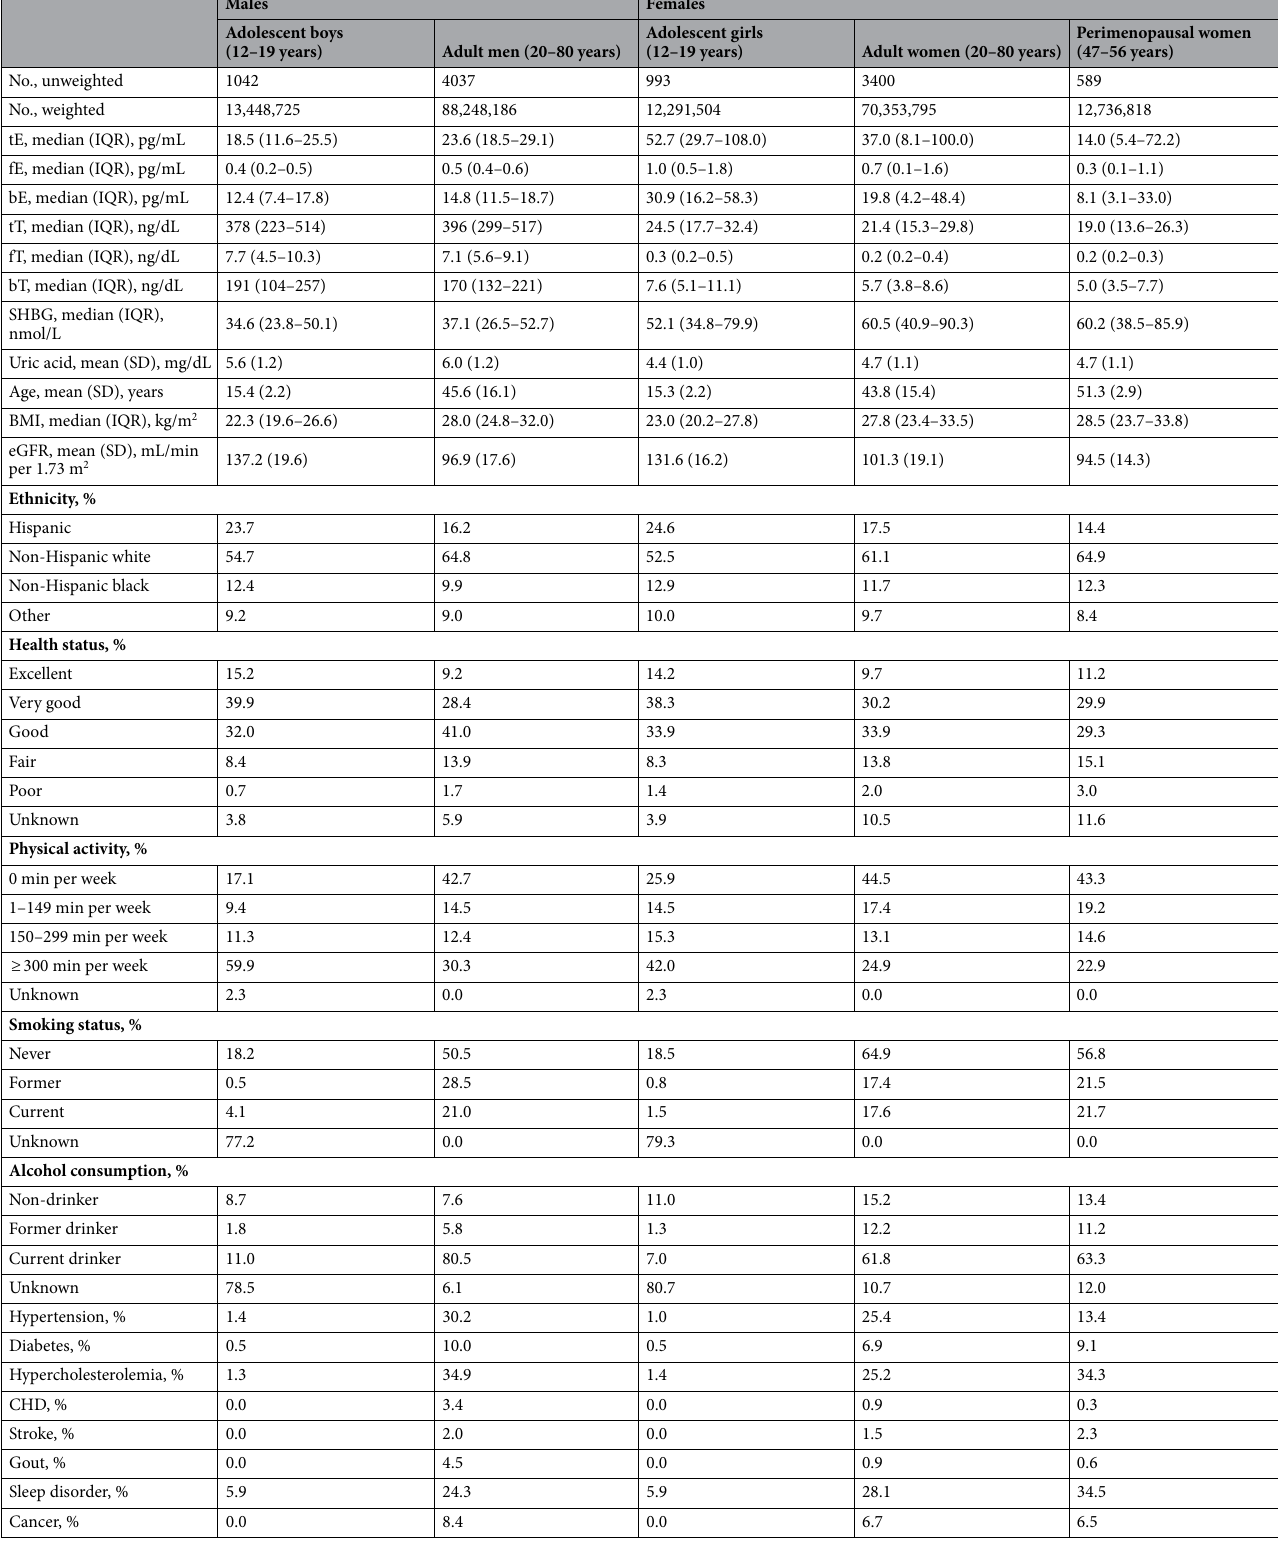
Table 1. Characteristics of the cohort stratified by sex and age. bE, fE or tE bioavailable, free or total estradiol; BMI body mass index; bT, fT or tT bioavailable, free or total testosterone; CHD coronary heart disease; eGFR estimated glomerular filtration rate; IQR interquartile range; No. number; SD standard deviation; SHBG sex hormone-binding